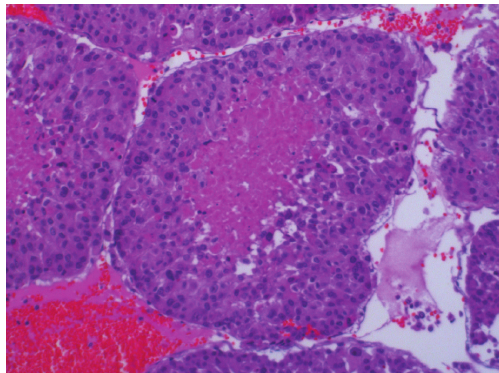
Figure 3: Papillar fragment of embolized tumour with necrotic axis and viable tumoral